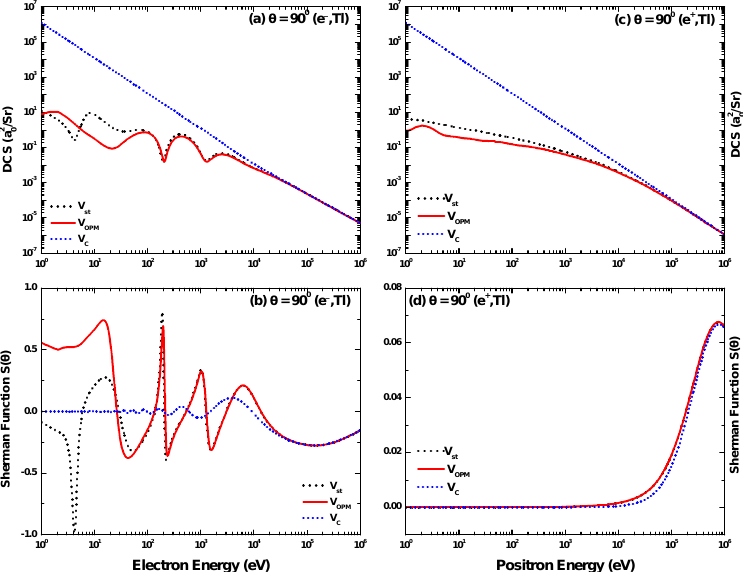
Figure 3. DCS and S ( θ ) for e ± − Tl scattering at 90 ○ as a function of incident energy. The effect of Coulomb potential is shown in (blue) dotted